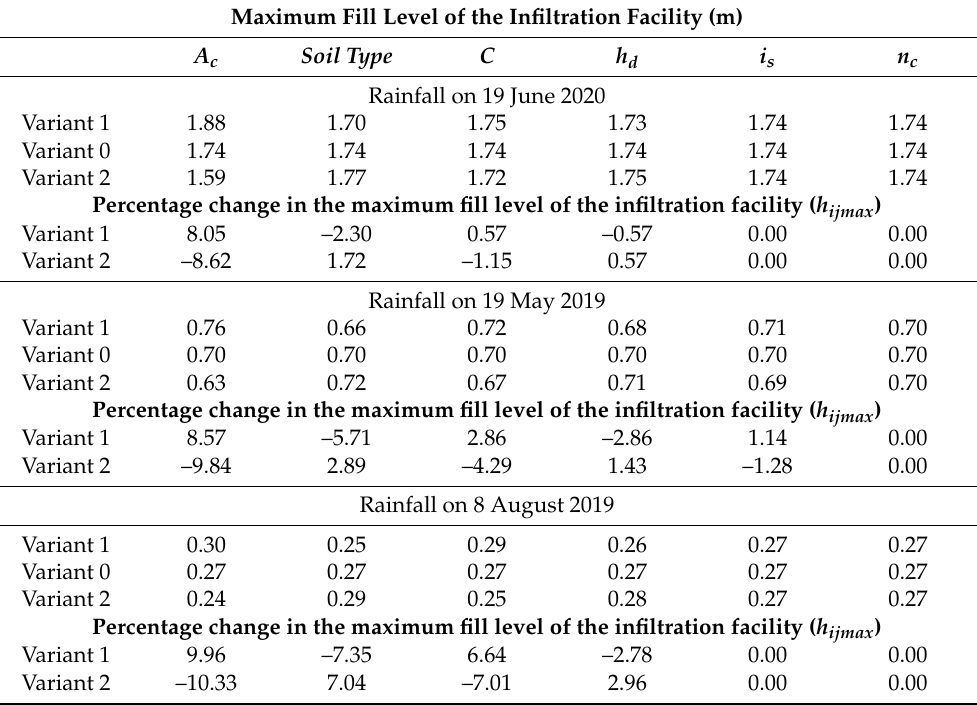
Table A7. Maximum fill level of the infiltration facility (designations as in Figure